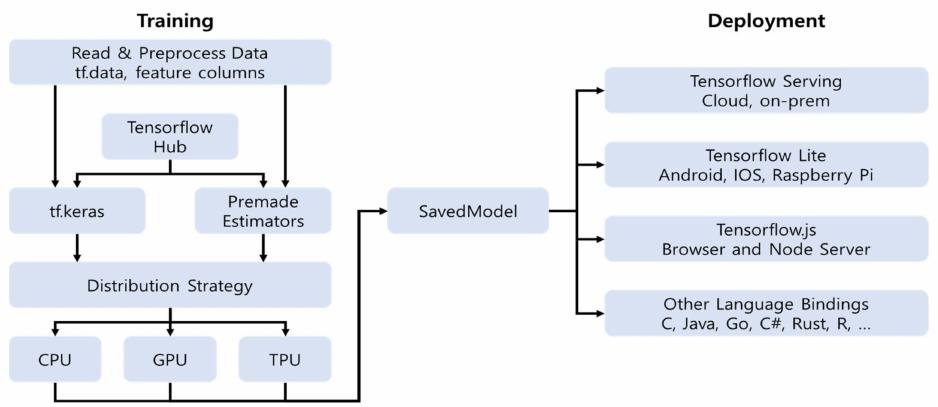
Figure 4. TensorFlow 2.0 version architecture and processing